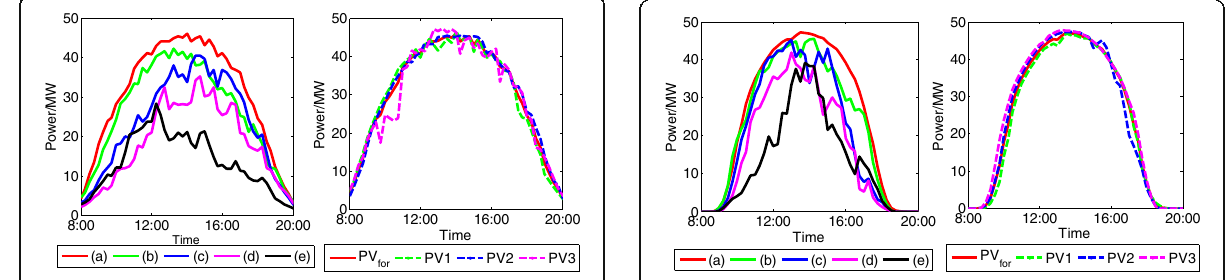
Fig. 5 Typical scenarios and the output curves of representative scenario in summer